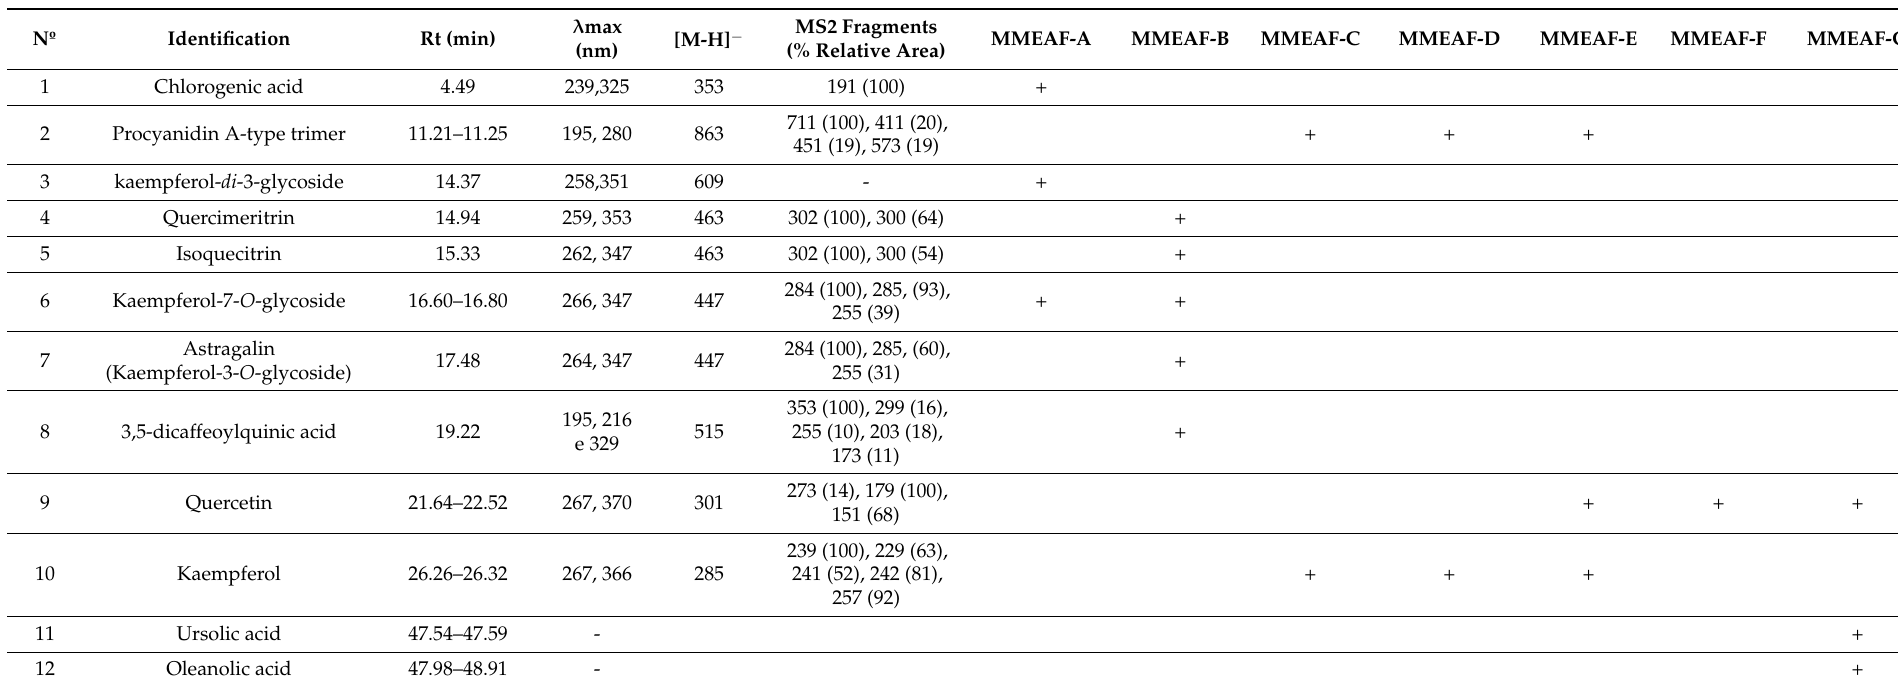
Figure 2. Chromatograms of the subfractions MMEAF-A–G analyzed by UHPLC-DAD-ESI-MS n and monitored at 254 nm. Table 1. Retention time (Rt), UV spectra, and MS/MS data of the compounds identified in the MMEAF subfractions (MMEAF-A-G).